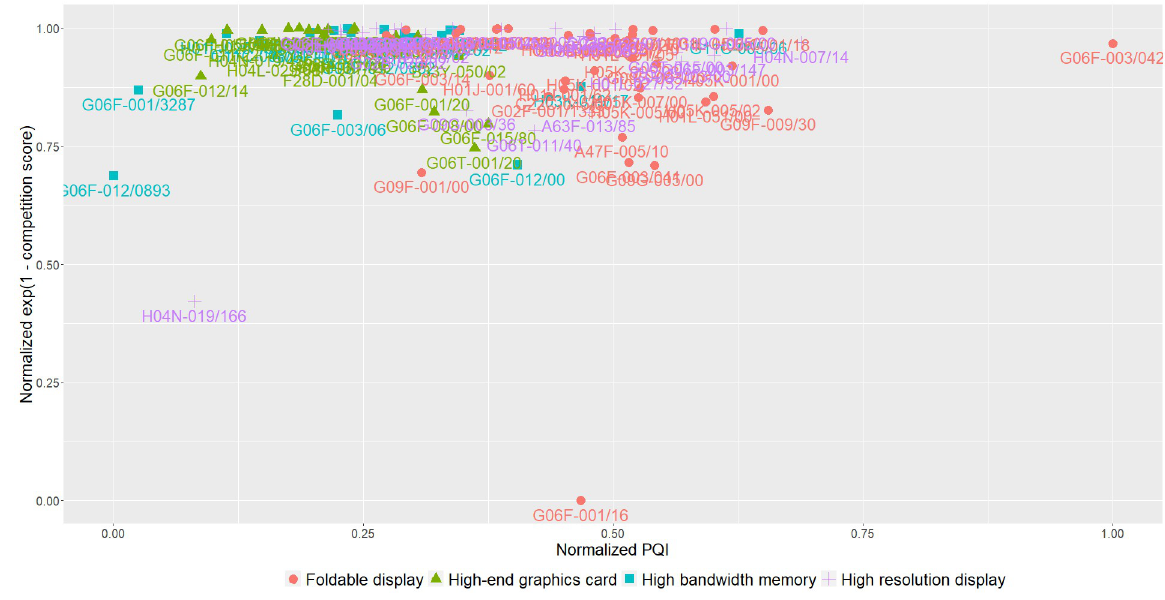
Fig 4. Mapping of the market value and competition of sub-technologies.